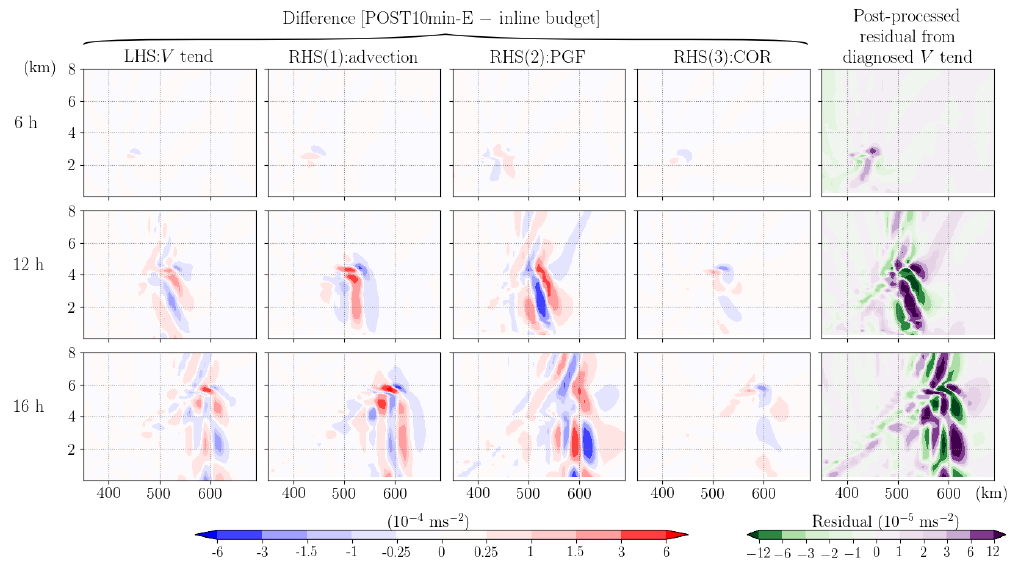
Figure 8. The difference between the post-processed (POST10min-E; with an explicit or forward method on 10min output) and inline budget analysis for the horizontal momentum, V . All terms have been divided by µ d and thus have a uniform unit of meters per second squared. In each row, from left to right indicates the difference for V tendency, ADV, PGF, and COR. The rightmost column indicates the residual term obtained in the post-processed budget analysis. Each row from top to bottom shows the results at 6, 12, and 16h, respectively.